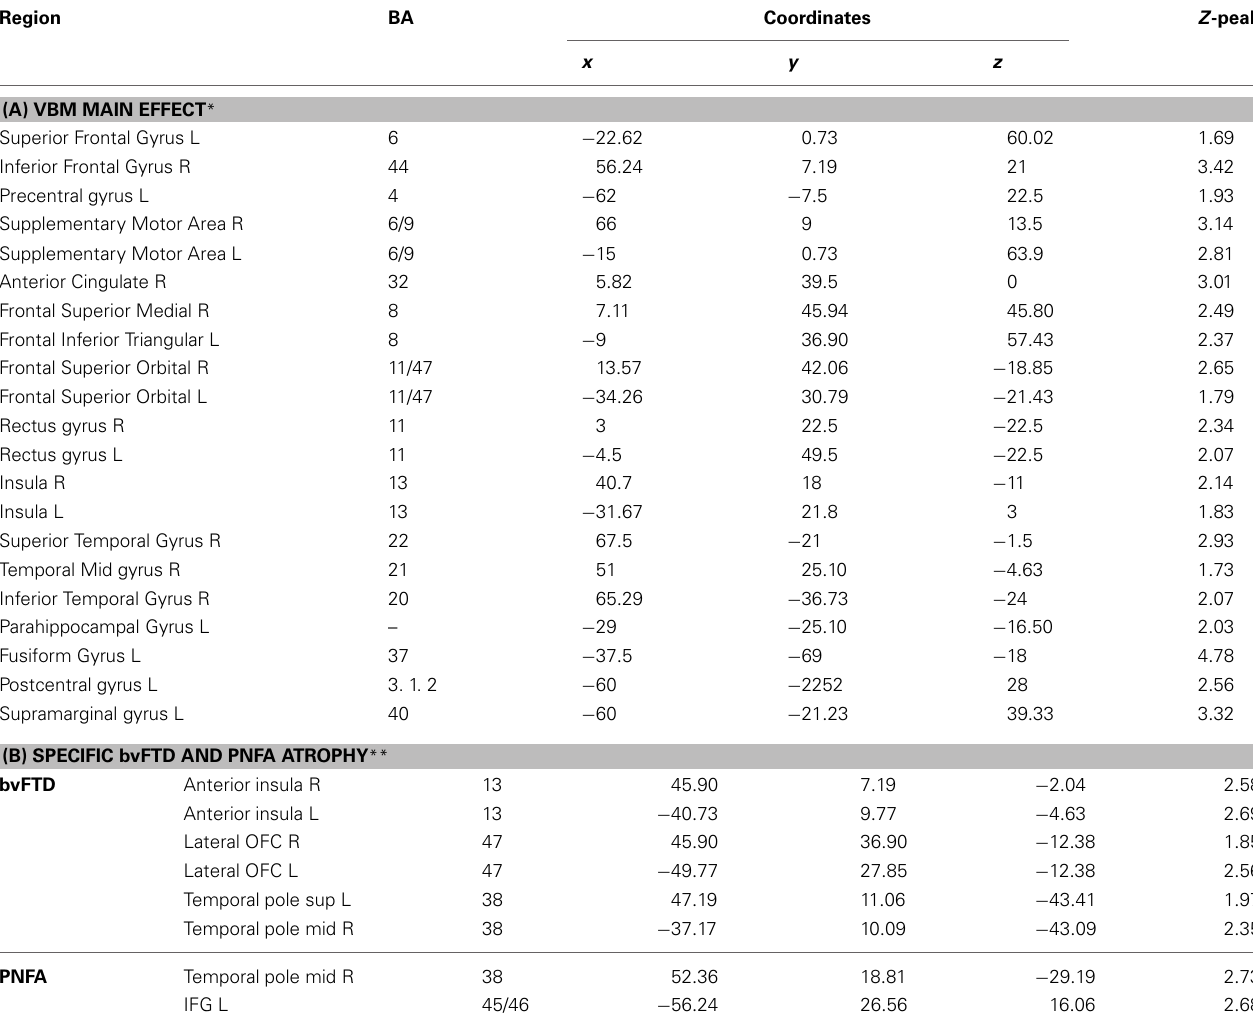
Table 3 | VBM results of whole brain atrophy of patients. Region BA Coordinates Z -peak